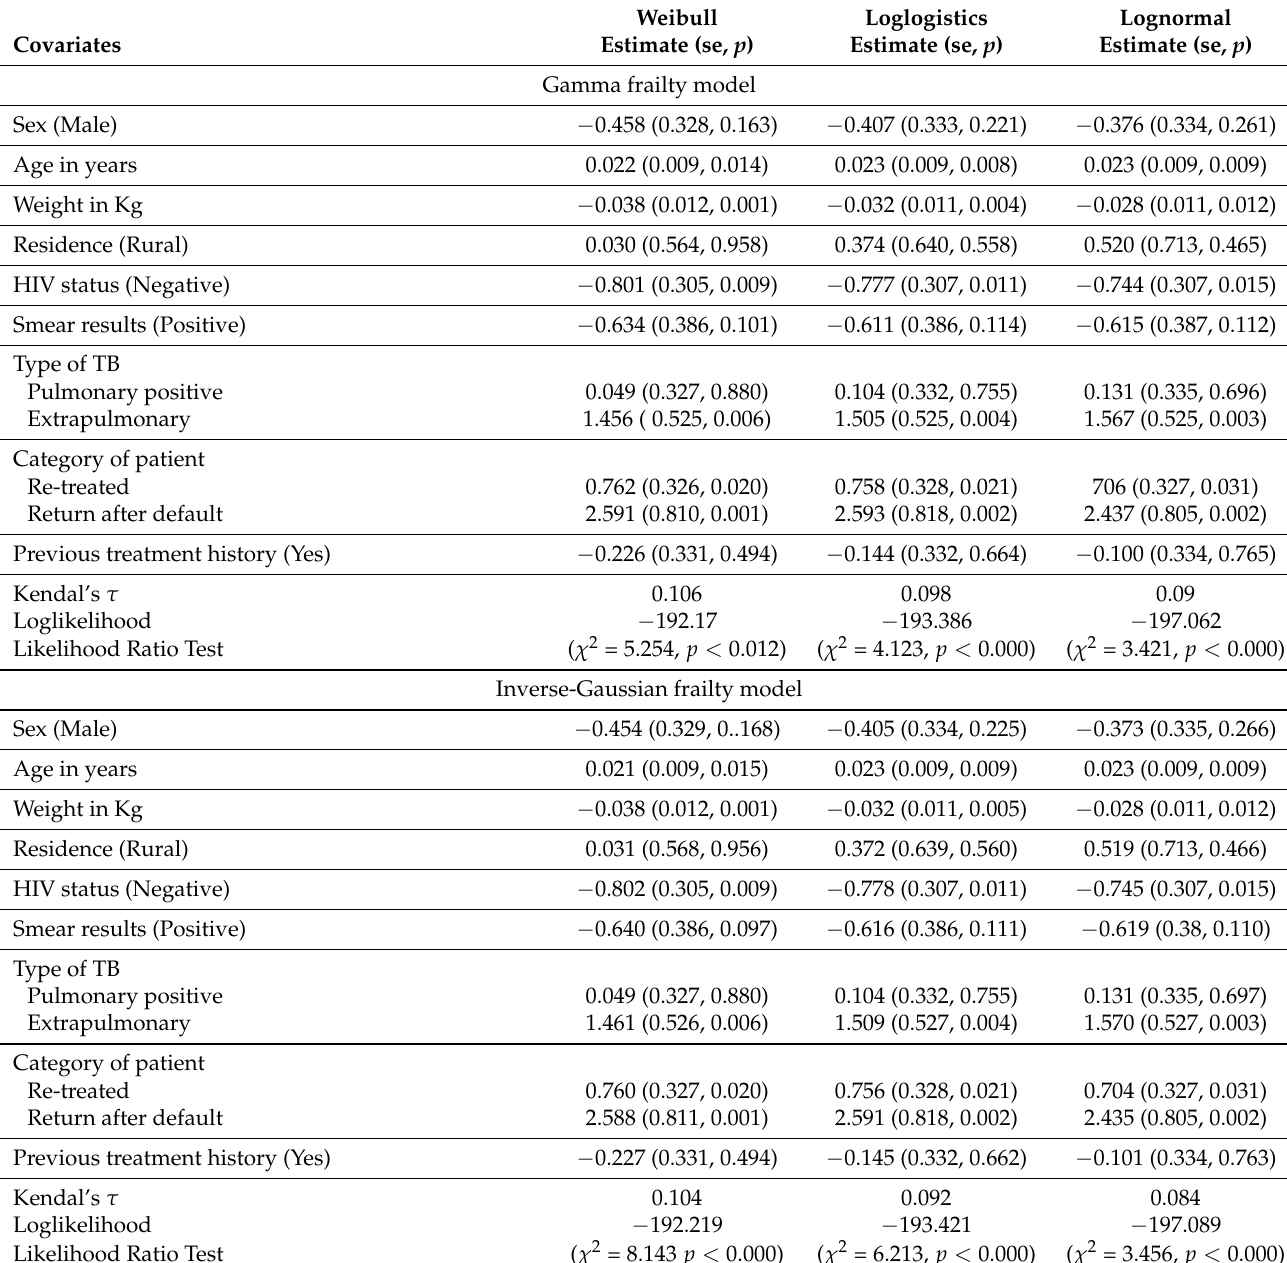
Table 5. Parameter estimates, standard error (se) and p -value ( p ) of Gamma and inverse-Gaussian shared frailty models for time to death of TB